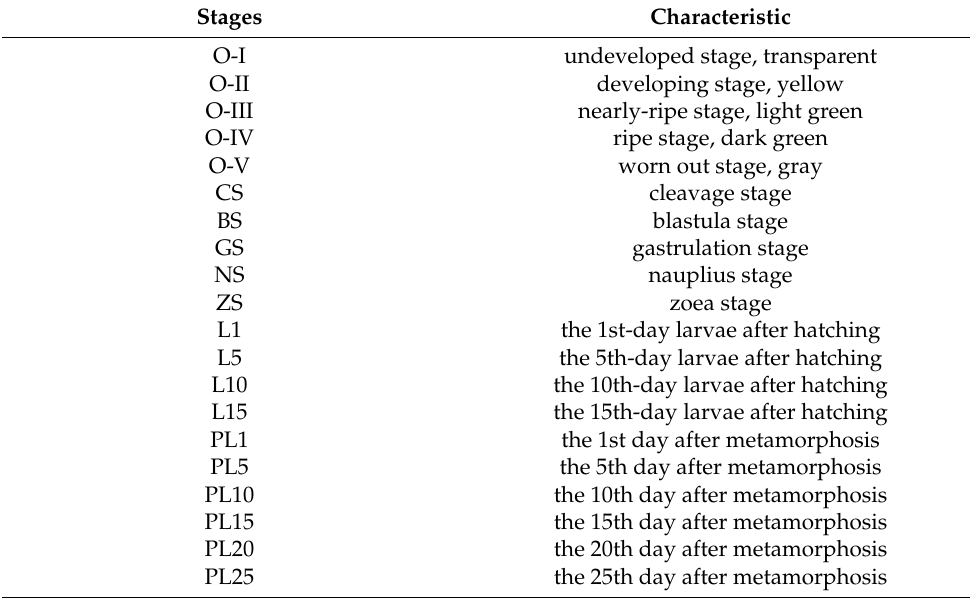
Table 1. Different developmental stages of ovary and embryo of M. nipponense . Stages Characteristic